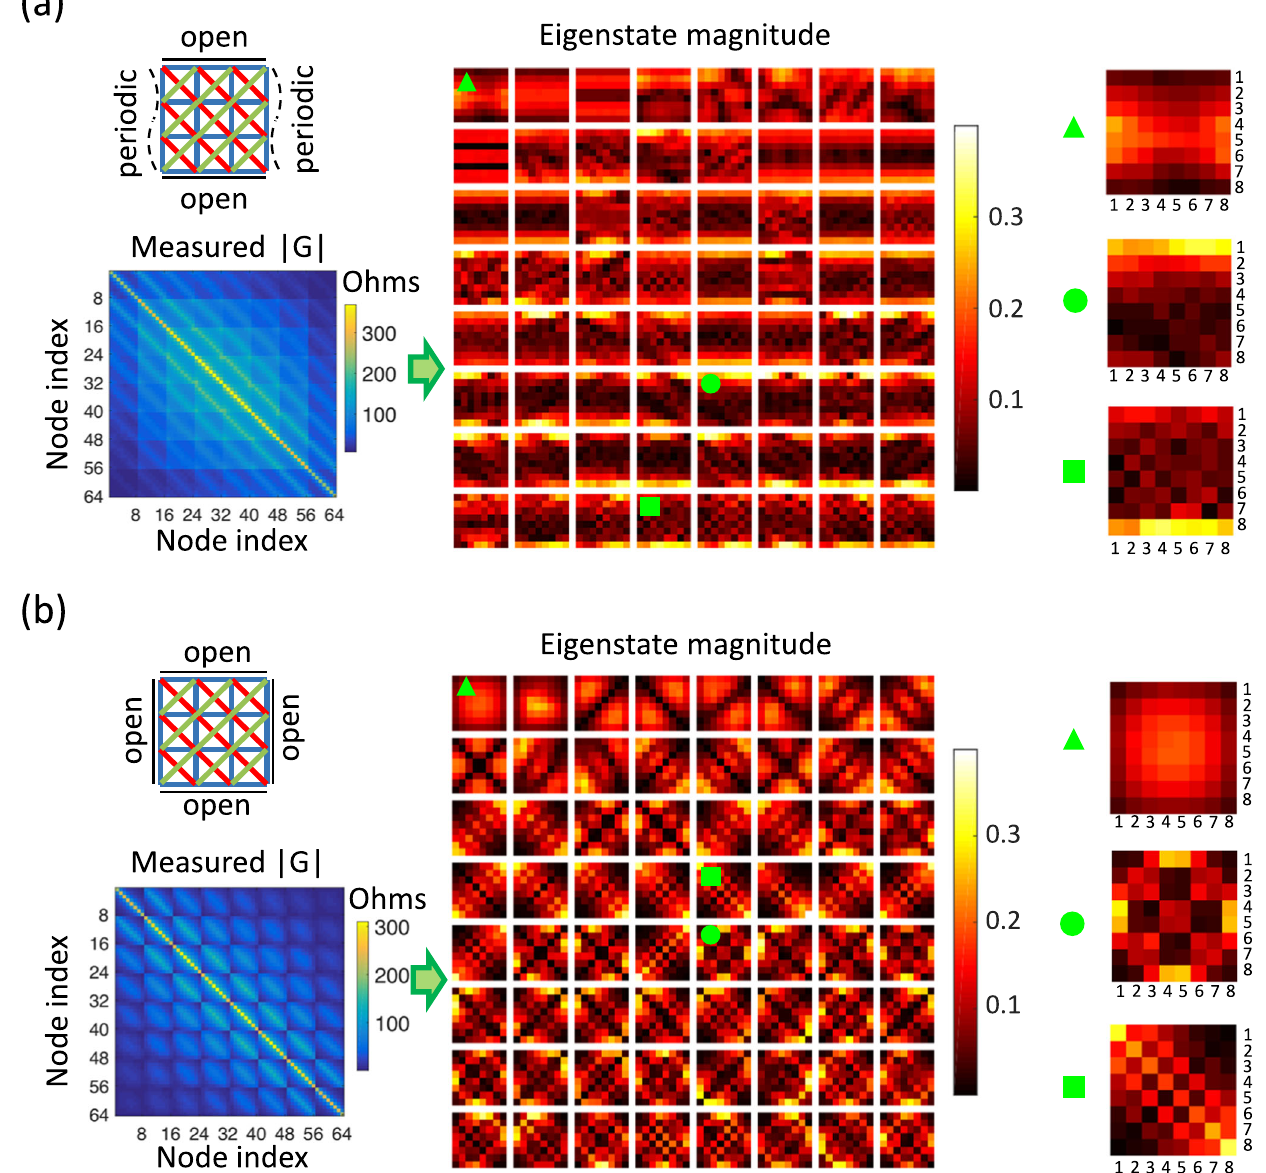
Fig. 3 | Measurements of cross-impedance matrix G and its eigenstates under cylinder and square geometries. a Visualization of the magnitude of measured matrix G (phase not presented) and its eigenstates under a cylinder geometry, where x -direction is periodic but y -direction isopen asshown in the top left panel. The lines with different colors in the top left panels correspond to different